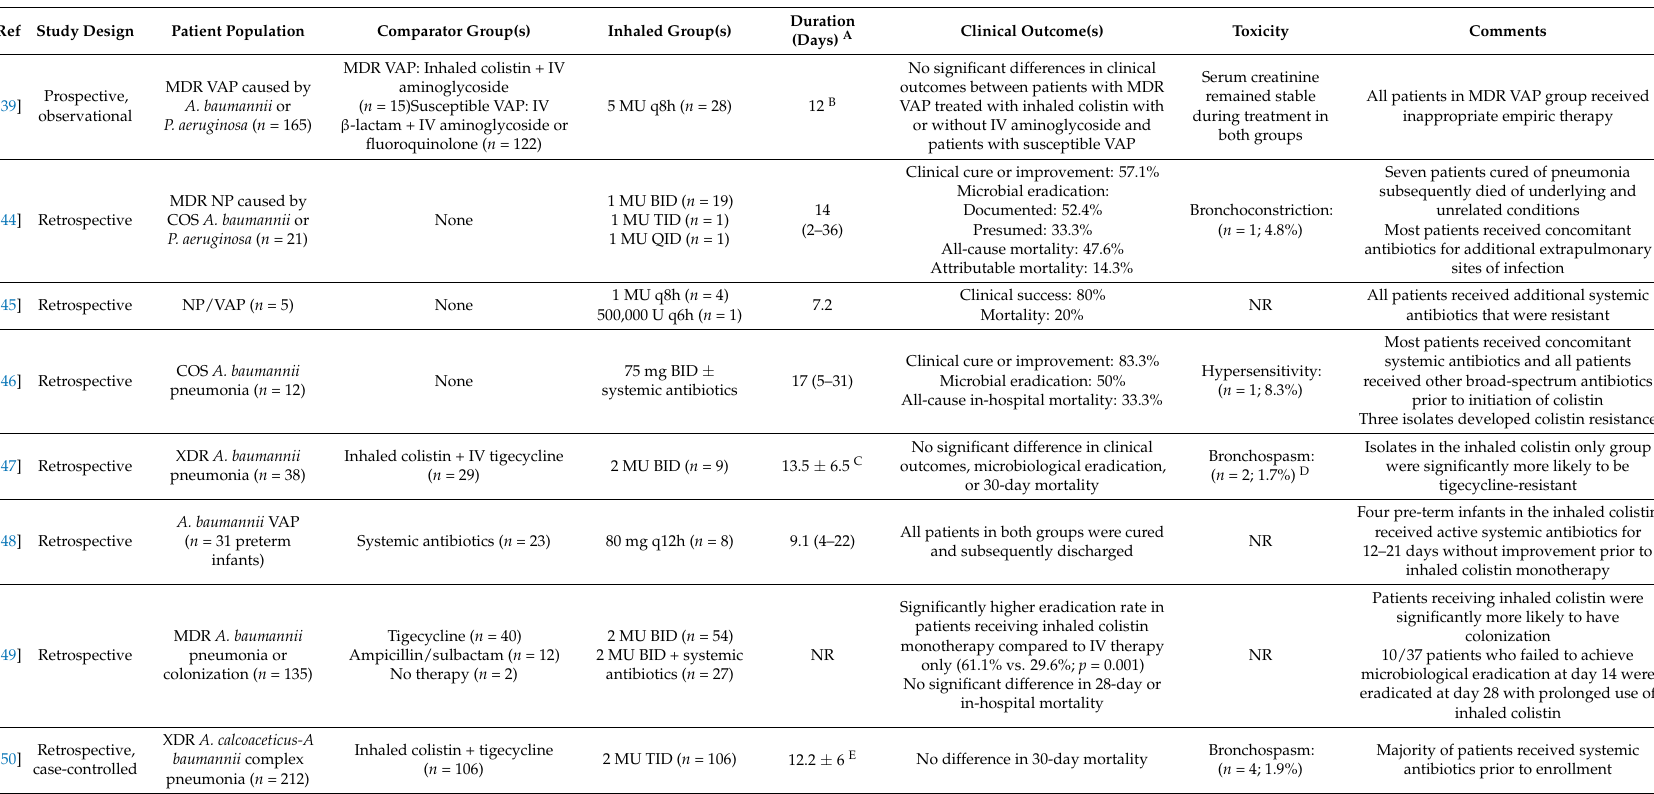
Summary of studies evaluating inhaled colistin without concomitant IV colistin for Gram-negative nosocomial pneumonia and/or ventilator-associated